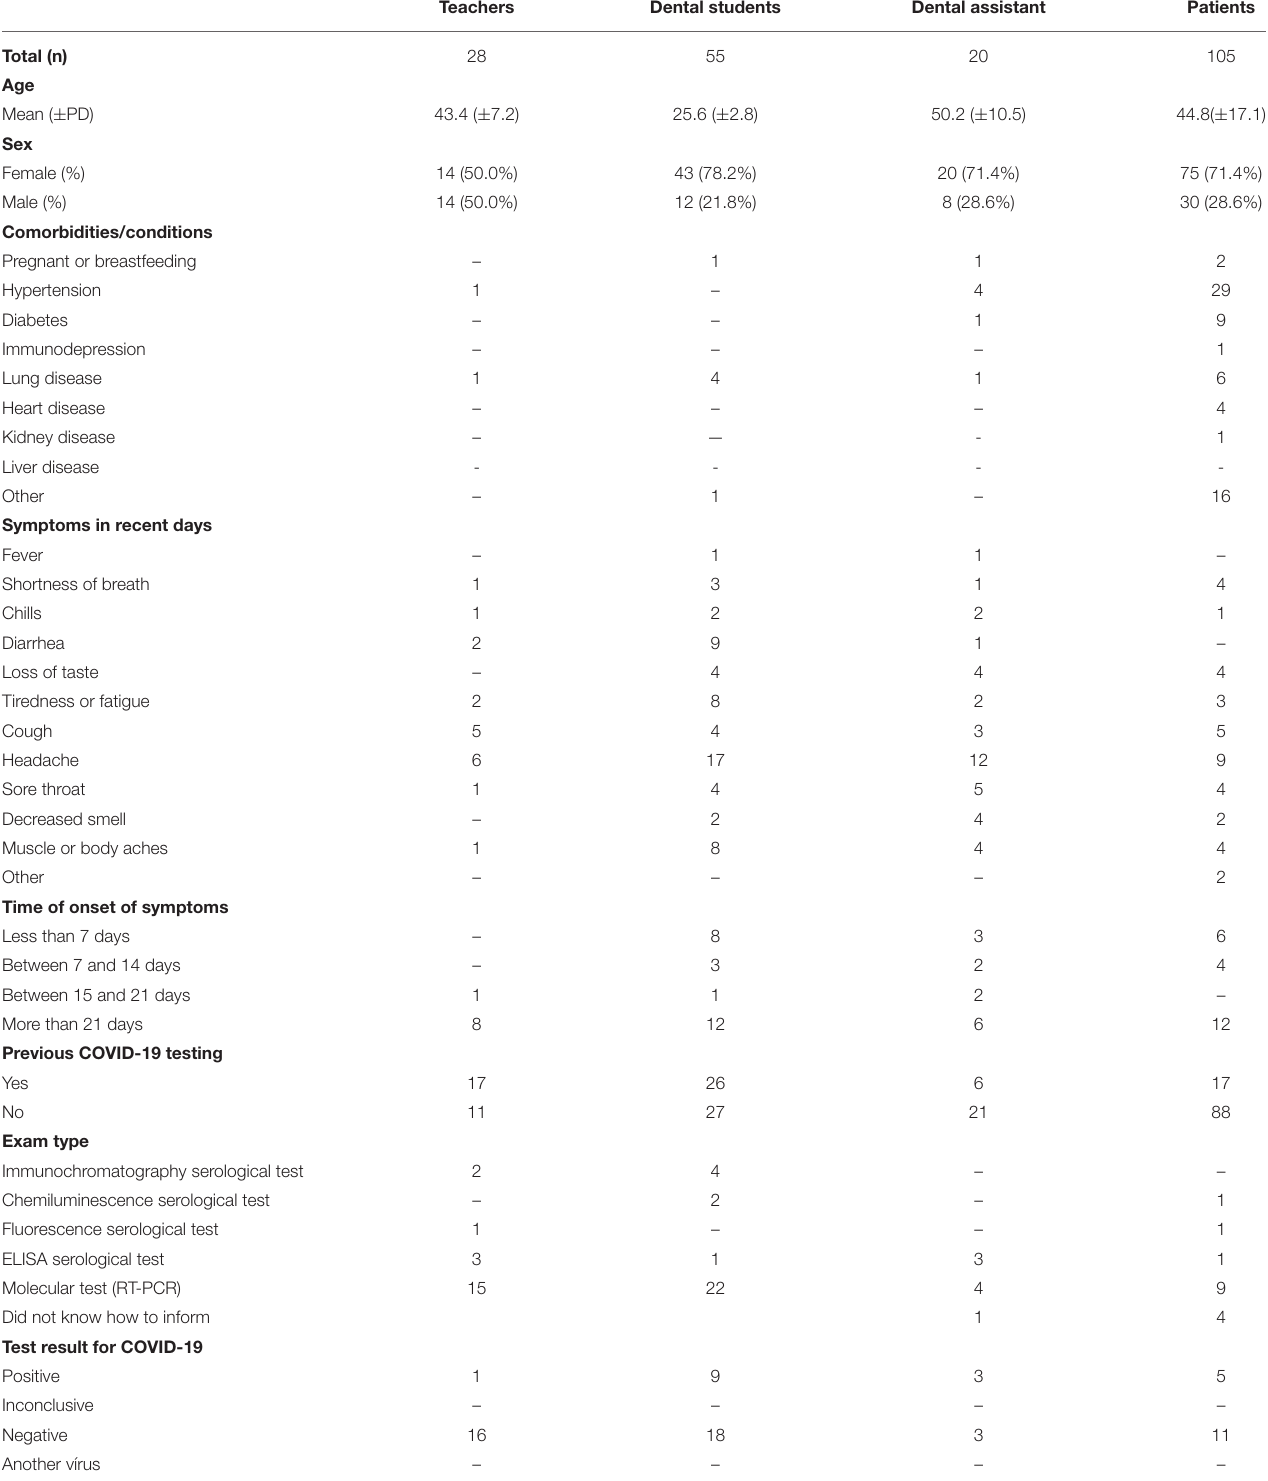
TABLE 1 | Demographic and clinical data of